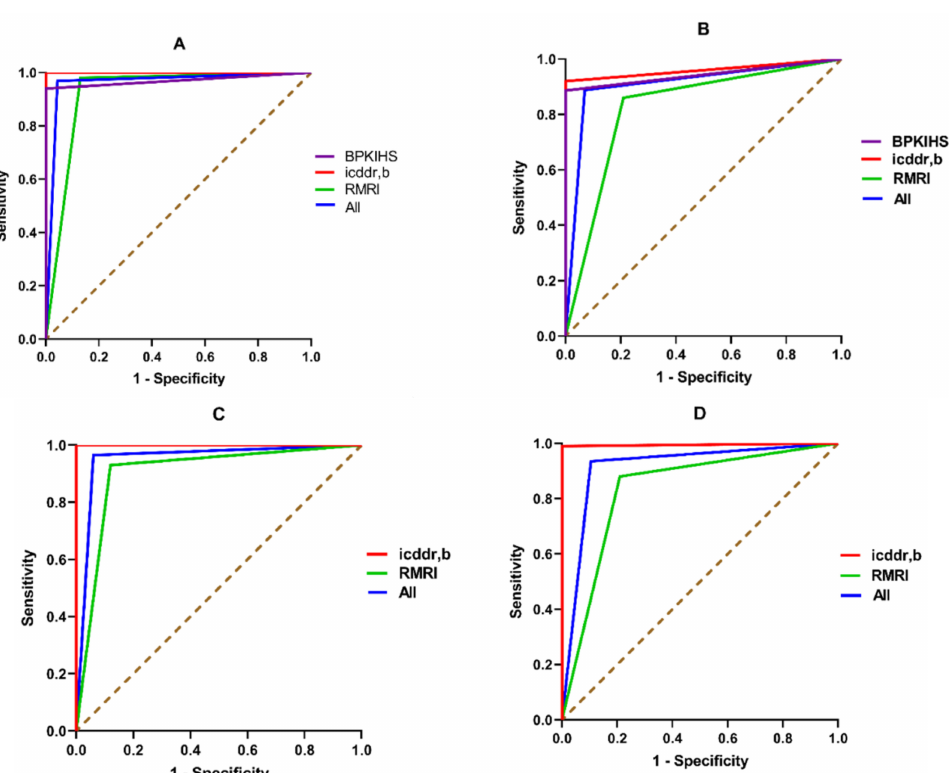
Figure 3. The receiver operating characteristic (ROC) curves depict the diagnostic accuracy of real-time PCR and RPA assays in diagnosis of both VL and PKDL with blood and skin specimens, respectively. ( A ) Area under the curves for real-time PCR in diagnosis of VL; ( B ) Area under the curves for RPA in diagnosis of VL; ( C ) Area under the curves for real-time PCR in diagnosis of PKDL; ( D ) Area under the curves for RPA in diagnosis of